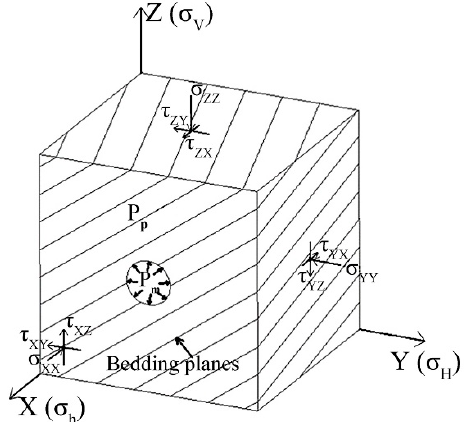
Figure 1. Hydraulic fracturing model of a horizontal well in the oil shale.